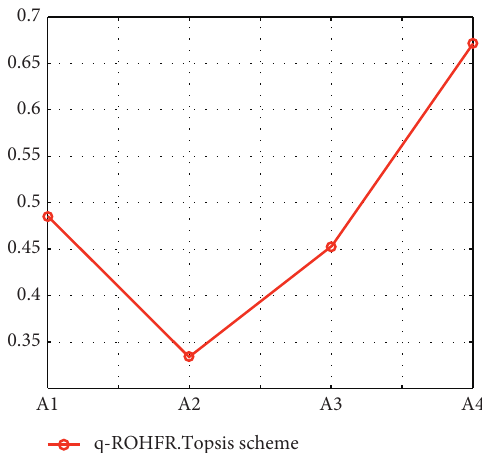
Figure 6: Alternatives using the TOPSIS technique.